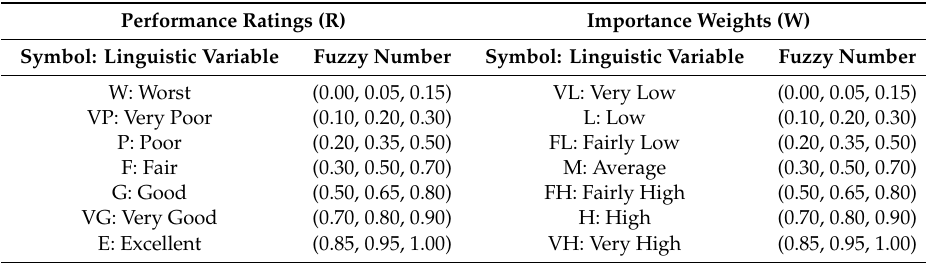
Table 3. Performance rating and weighting scale with corresponding fuzzy